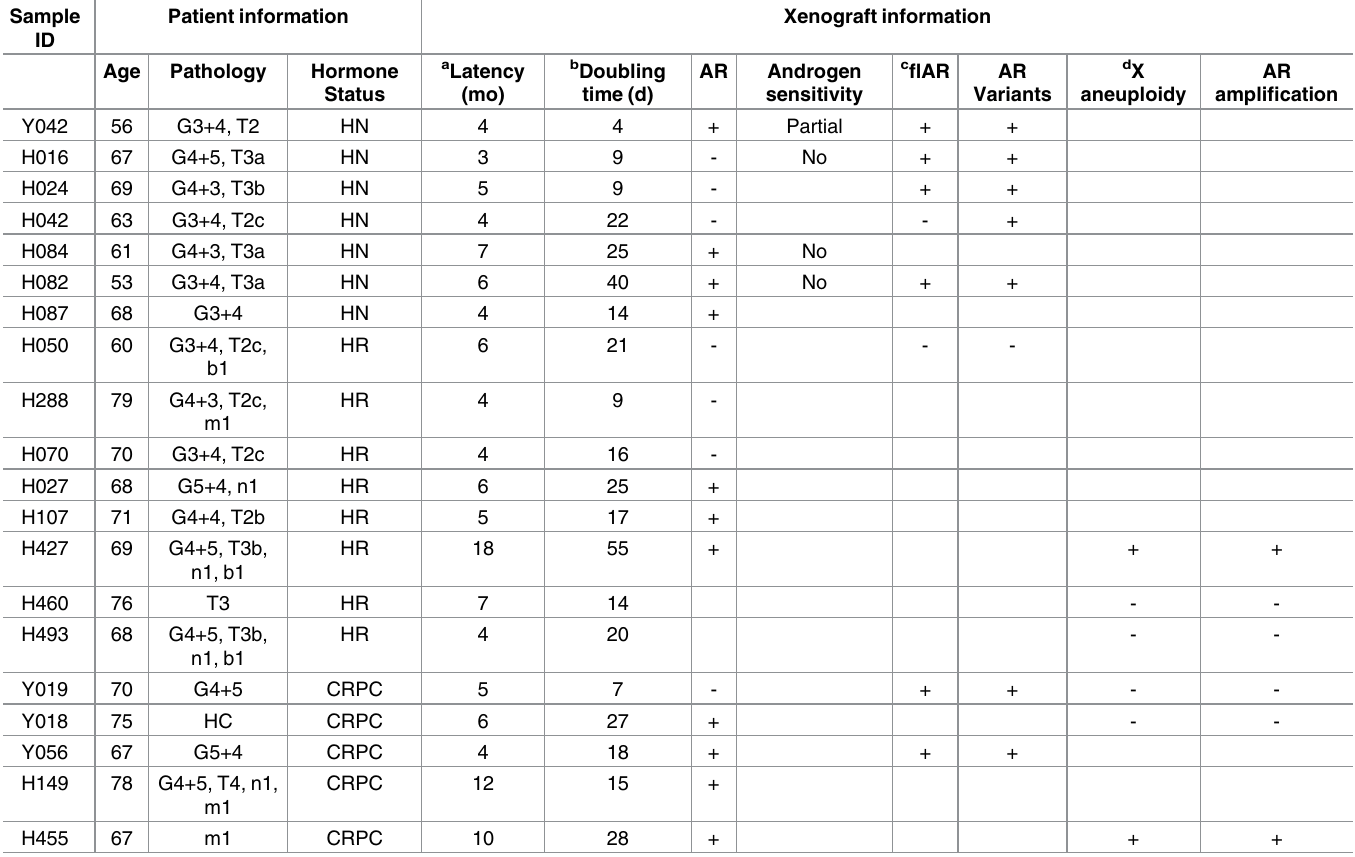
Table 1. Characteristics of xenografts and corresponding donor